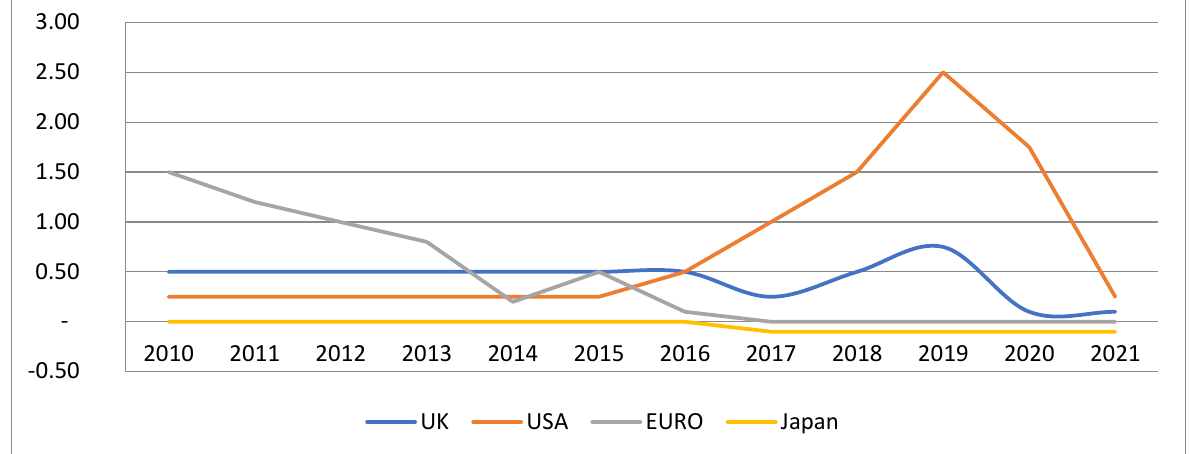
Figure 6. Changes in the base rate (%) in the years 2010 – 2021. Source [78 – 85].